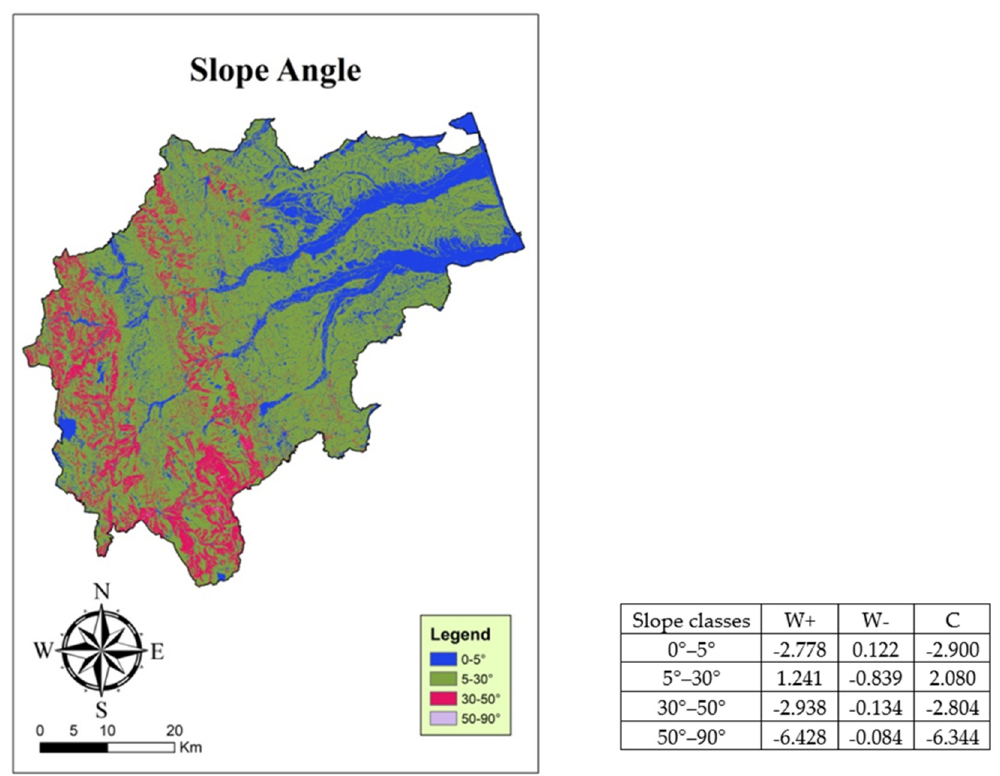
Figure 6. ( Left ) Map of slope angle of Macerata province; ( Right ) The weights calculated for the slope parameter. The most frequent class of lanslides for the slope angle is between 5° and 30°, while C for all the other classes seems to be not very significant (Figure 6).